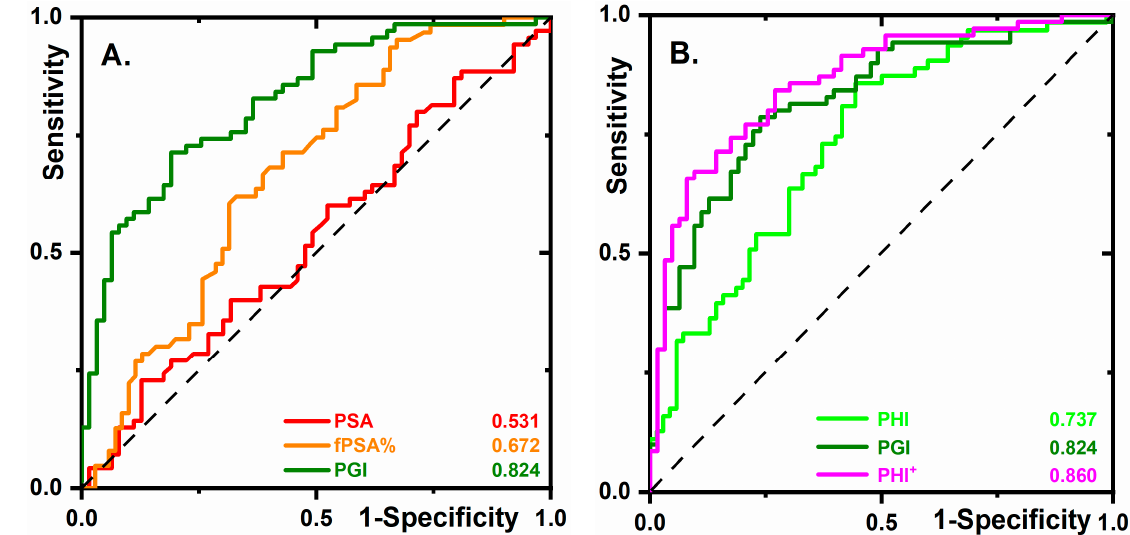
Figure 2. ( A ) ROC curves for the same biomarkers as shown in Figure 1A but using the 133 samples in total (63 samples from the non-cancer cohort and 70 samples from the PCa cohort). ( B ) ROC curves for PHI, PGI, and PHI+ (PHI combined with PGI), obtained by analysis of the 133